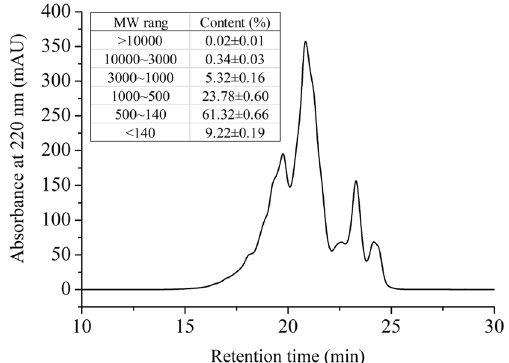
Figure 1. Chromatogram of WOP showing the molecular weight (MW) distribution. The inset shows the contents of peptides with different classes of MW ranges in